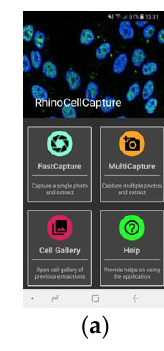
Figure 10. App home page ( a ), app field gallery ( b ).